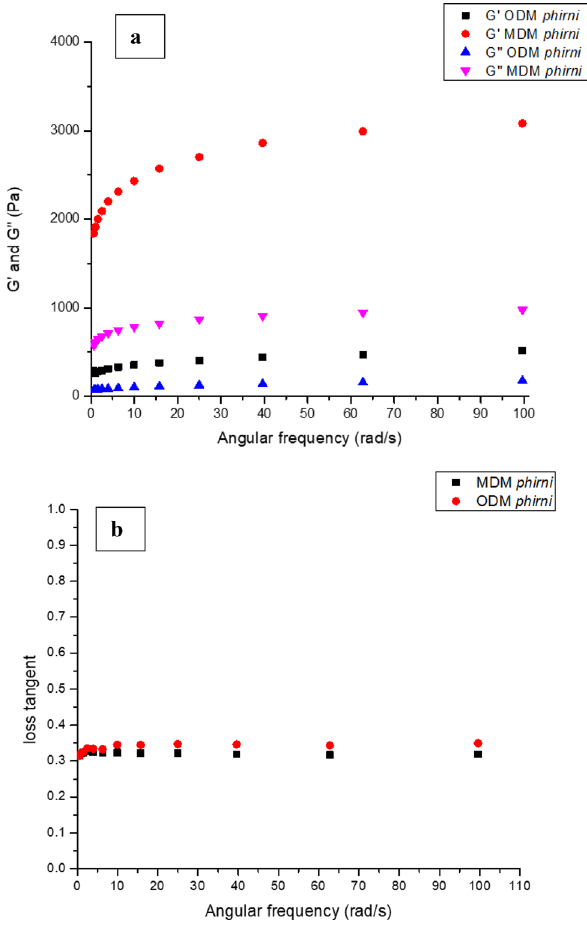
Figure 3. ( a ) G ʹ and G ʹʹ and ( b ) Loss tangent of phirni reconstituted from ODM and